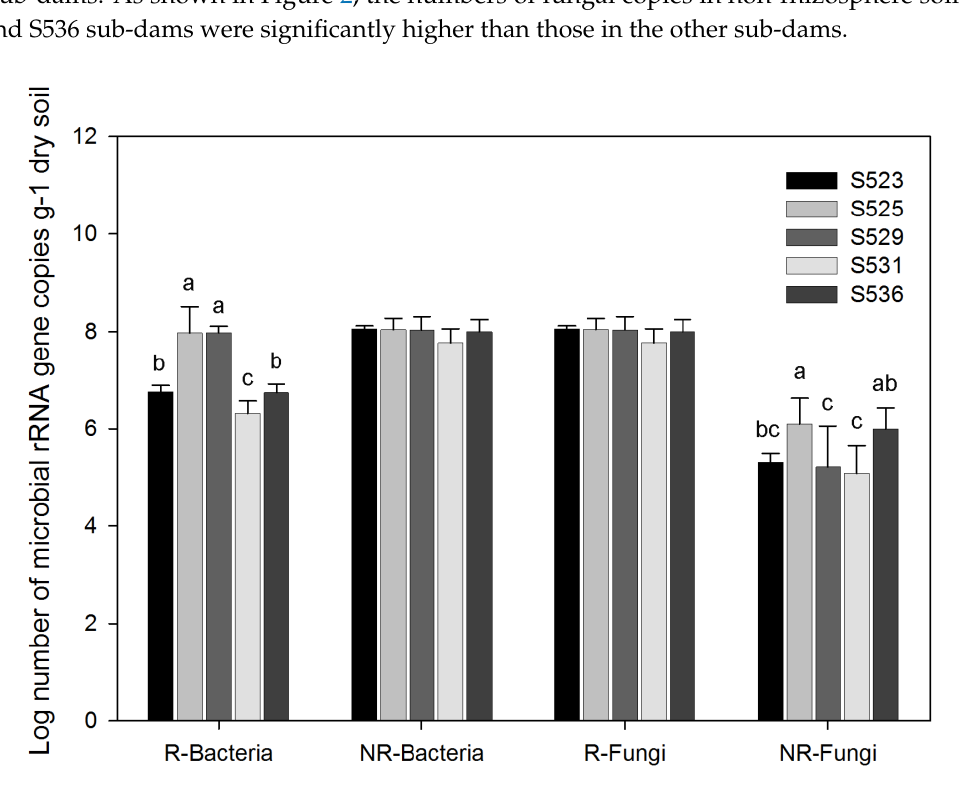
Figure 2. Abundance of rhizosphere (R) and non-rhizosphere (NR) soil bacteria and fungi rRNA genes in different sub-dams. Points show the means of five replicates, and vertical bars show standard errors. The different letters (a, b and c) indicate that the means are significantly different among restored sub-dams ( p < 0.05) with the Duncan test.